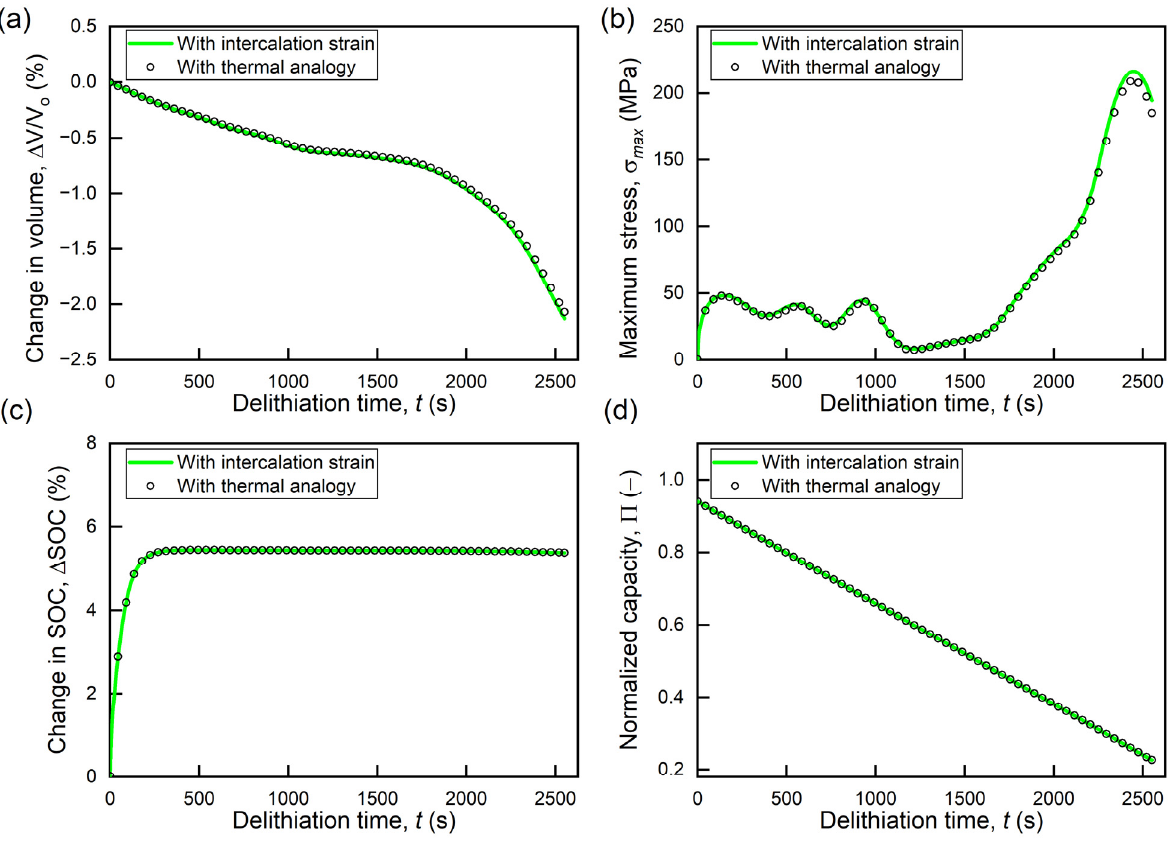
Figure 4. Validation of the use of concentration-dependent partial molar volume by performing simulations by intercalation strain and thermal analogy methods. ( a ) change in the total volume of the active particle ( ∆ V/V o ), ( b ) the maximum value of the local first principal stress ( σ max ), ( c ) the difference between maximum and minimum local charge states ( ∆ SOC ), and ( d ) the normalized lithium charge capacity (Π) inside the active particle.